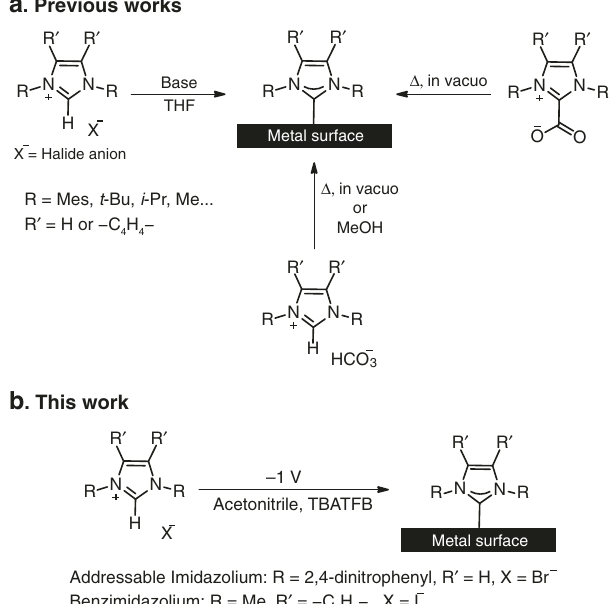
Fig. 1 Methodologies for preparation of NHCs-based SAMs. a NHC-based SAMs formation is mainly facilitated by deprotonation of imidazolium salt precursors with inorganic base or by using speci fi cally synthesized precursors such as NHC(H)[HCO 3 ] salts or NHC – CO 2 adducts. b In this work an alternative approach is demonstrated in which SAMs of NHCs are prepared on metal surfaces (Au, Pt, Pd, and Ag) by electrochemically induced deprotonation of 1,3- bis (2,4-dinitrophenyl)-imidazolium bromide and 1,3-dimethyl-benzimidazolium iodide salt precursors.